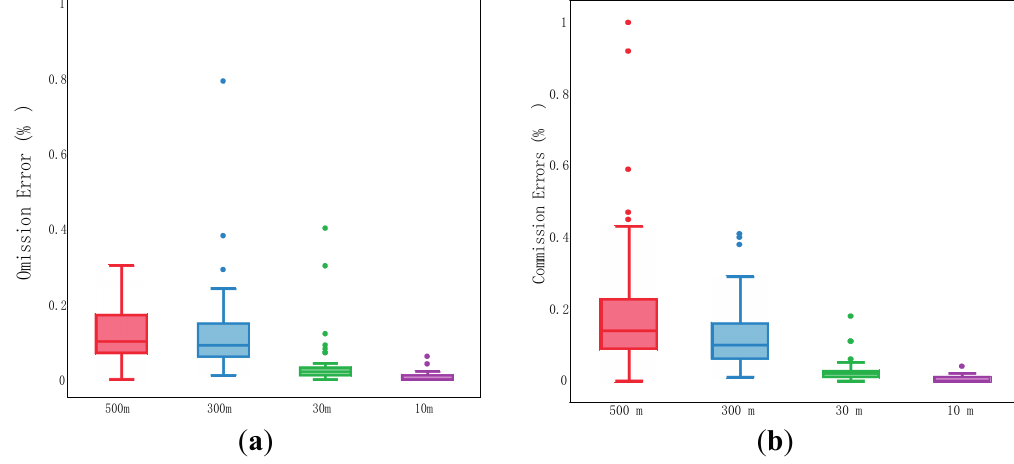
Figure 9. Comparison of the “optimal” accuracy of the MODIS LCP (500 m) and the “optimal” accuracy obtained using the simulated data with 300 m, 30 m and 10 m spatial resolutions at the 55 validation sites for the cropland classes. The “optimal” accuracy was extracted from the Pareto Boundary; ( a ) omission errors and ( b ) commission